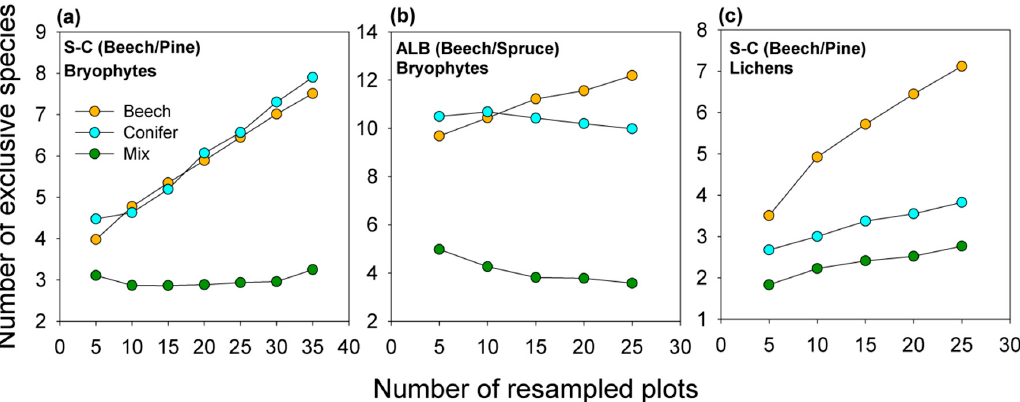
Figure A6. Number of exclusive bryophyte ( a,b ) and lichen ( c ) species in relation to the number of resampled plots in pure beech and conifer stands and respective mixtures in ( a , c ) Schorfheide-Chorin (S-C) and ( b ) Schwäbische Alb (ALB).